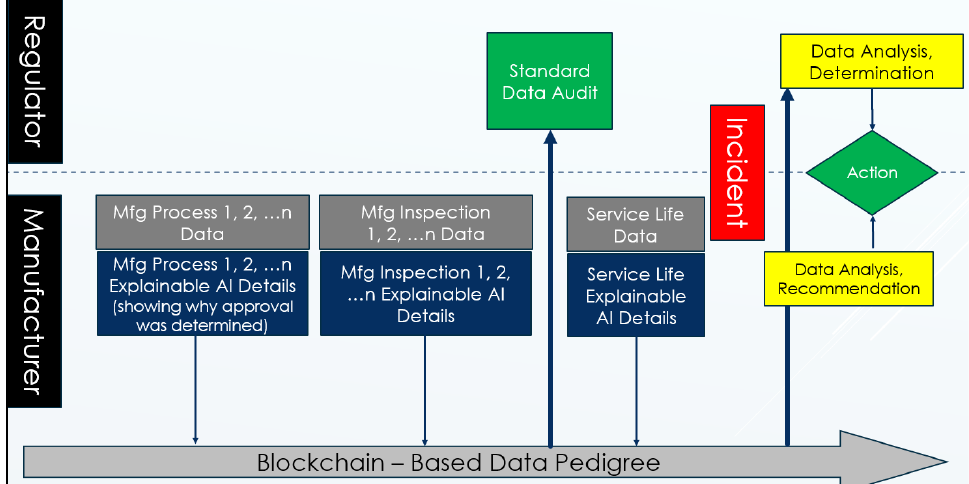
Figure 7. Blockchain immutability for digital thread audits/investigations.